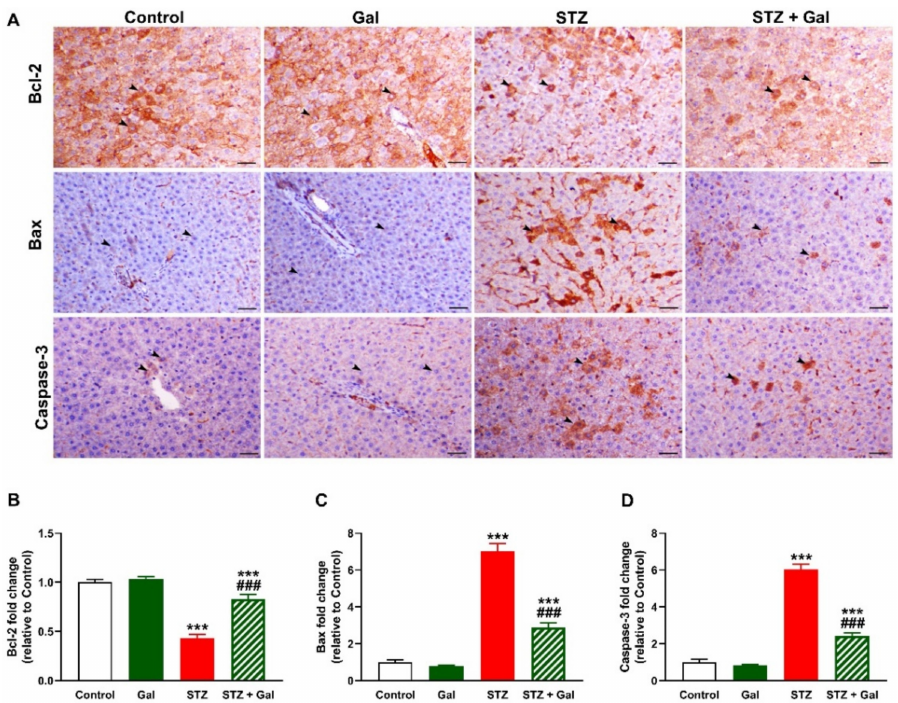
Figure 10. Galangin attenuates apoptosis in diabetic rats. ( A ) Photomicrographs of liver sections showing marked expression of Bcl-2 and mild expression of Bax and caspase-3 in control and Gal-treated rats, marked decrease in Bcl-2 and increased Bax and caspase-3 in diabetic rats, and ame- liorated expression of all markers in diabetic rats treated with Gal (arrowheads) (Scale bar = 50 µ m). ( B – D ) Gal increased Bcl-2 ( B ) and decreased Bax ( C ) and caspase-3 ( D ) in diabetic rats. Bax and caspase-3 were determined by counting the positive cells per 1000 hepatocytes, while Bcl-2 positive staining was assessed using ImageJ (version 1.32j, NIH, Bethesda, MD, USA). The results are ex- pressed as fold change relative to control. Data are mean ± SEM, n = 6. *** p < 0.001 versus control and ### p < 0.001 versus